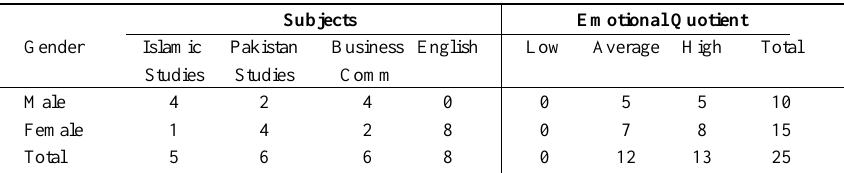
Table 2 Cross Tabulation of Gender with Subjects and